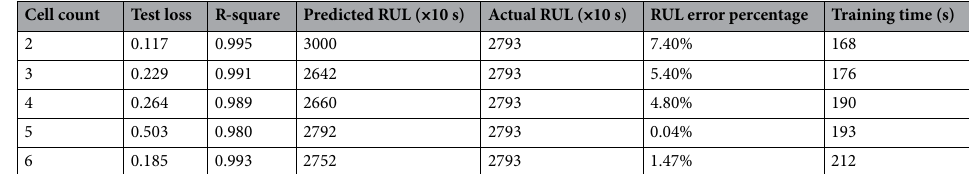
Table 8. Performance comparion for training bearing 1_1 using CNN with the different number of